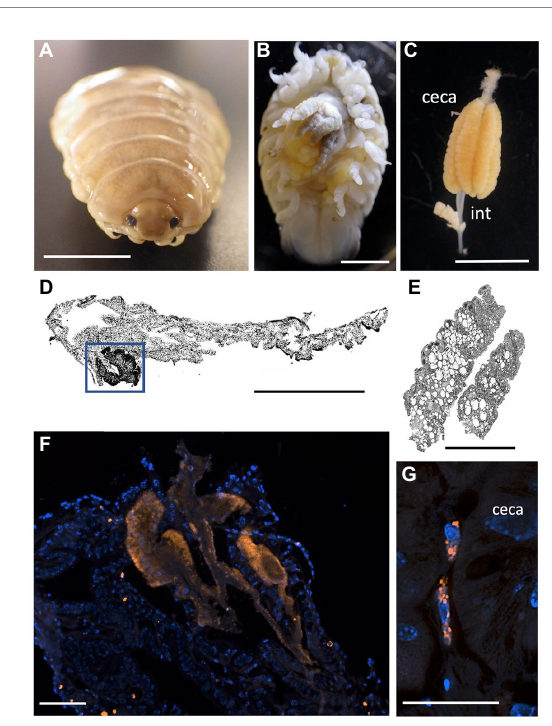
FIGURE 5 Fluorescent visualization and localization of Vibrio in (A) the parasitic isopod Elthusa vulgaris . (B) Ventral dissection showing the enlarged digestive ceca. Scale bar 5 mm. (C) Excised digestive ceca and intestine. Scale bar, 4 mm. A-C were taken with a Pentax WG-III handheld camera. (D) intestine sectioned and Wright stained. Scale bar, 1 mm. Square indicates region in F . (E) ceca sectioned and Wright stained. Scale bar, 1 mm. (D,E) Imaged via light microscopy. (F) A Vibrio -specific fluorescent probe, shown in orange with Cy3, revealed a strong signal within a darkly stained area of the intestine, near the ceca junction. Scale bar 100 μ m. (G) Vibrio cells, shown in orange, observed inside of cells, at a specific junction between the midgut and the anterior digestive ceca. Scale bar 20 μ m. Isopod nuclei are shown in blue, via DAPI. int.,